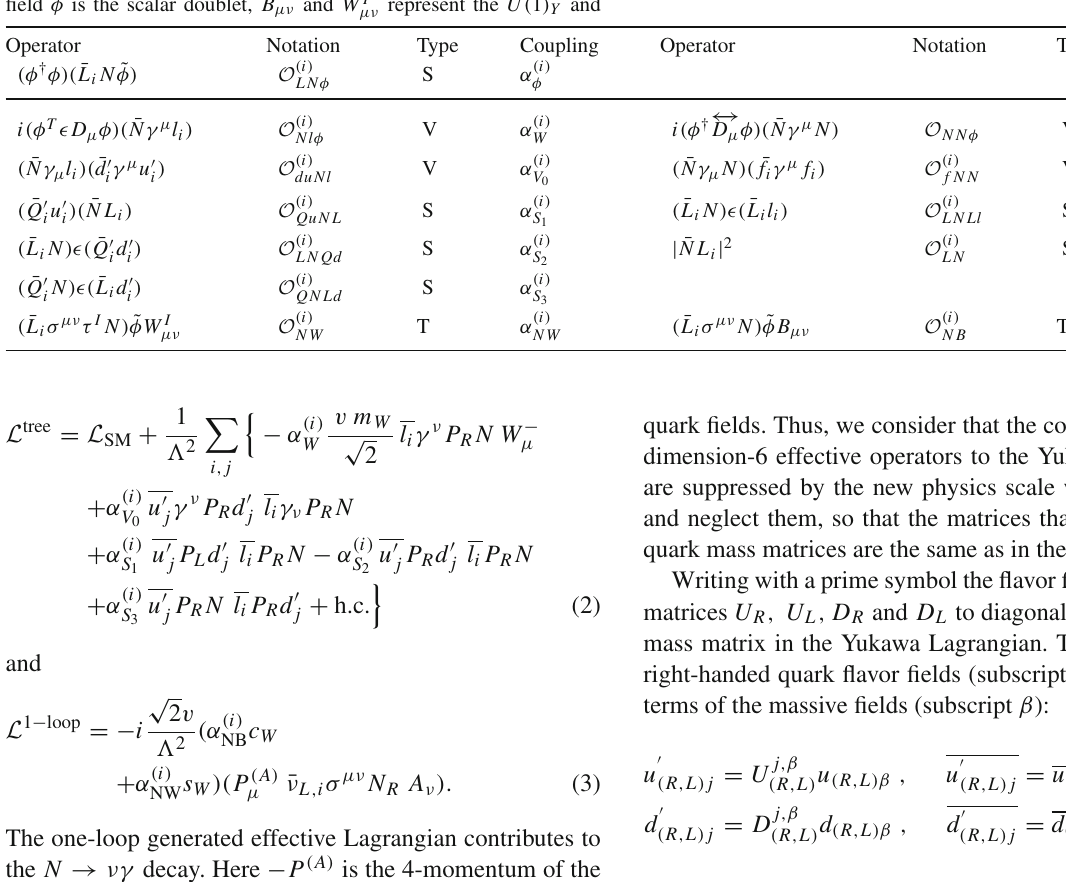
SU(2) L field strengths, respectively. Also σ μν is the Dirac tensor, γ μ , d (cid:5) and are the Dirac matrices, and (cid:11) = i σ 2 is the antisymmetric symbol in two i i dimensions. Types V , S and T stand for scalar, vectorial and tensorial (one-loop level generated)